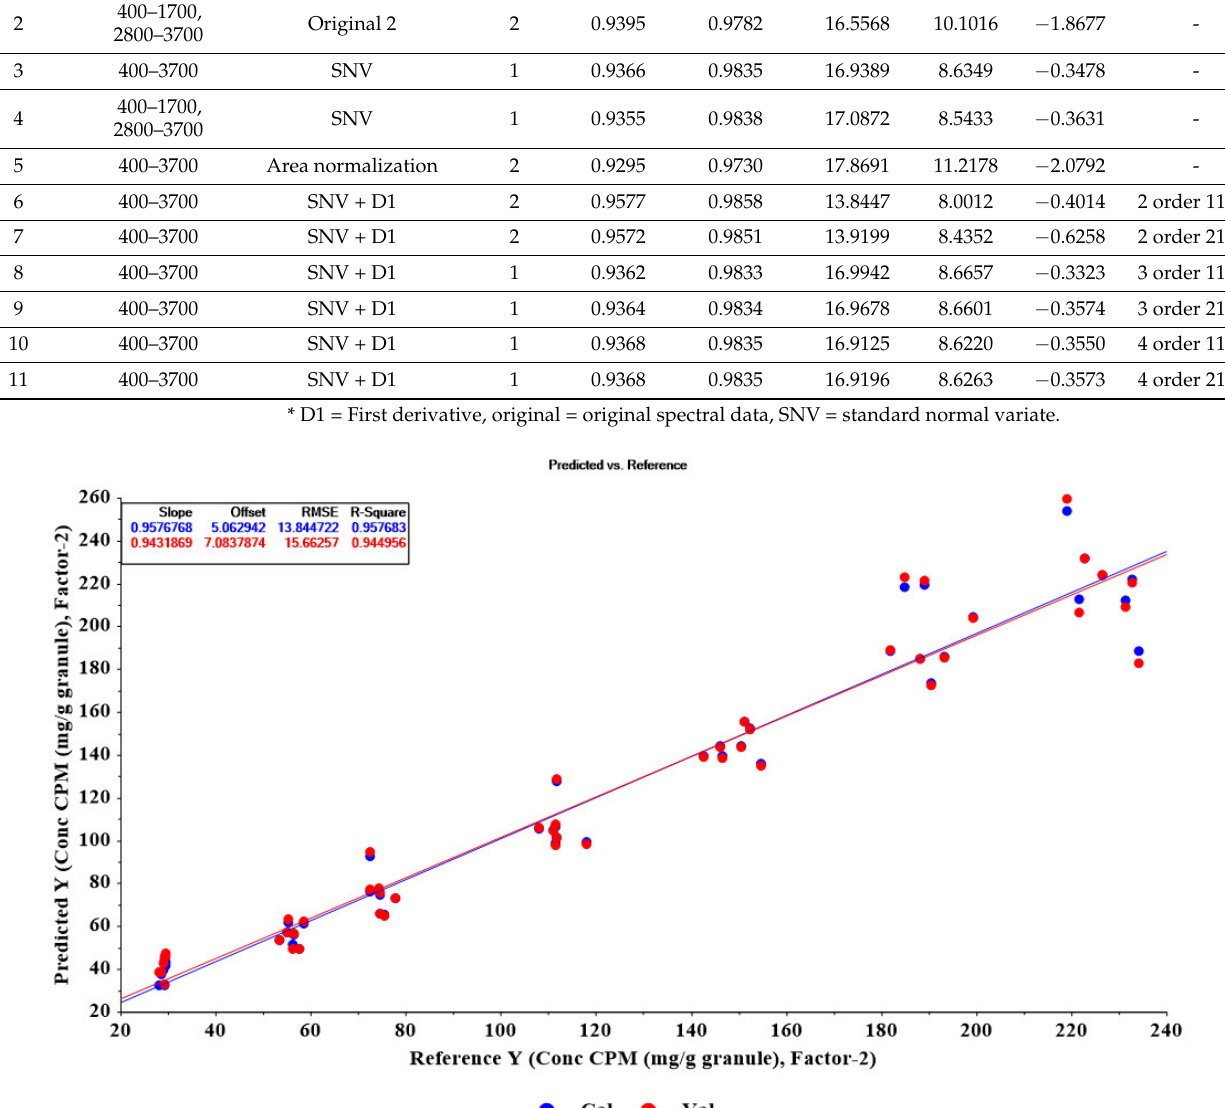
and cross-validation samples indicating that the data are appreciated and modelled, the closer the slope is to 1, R 2 of model (R 2 calibration) and R 2 validation are close together, indicating a good fit of